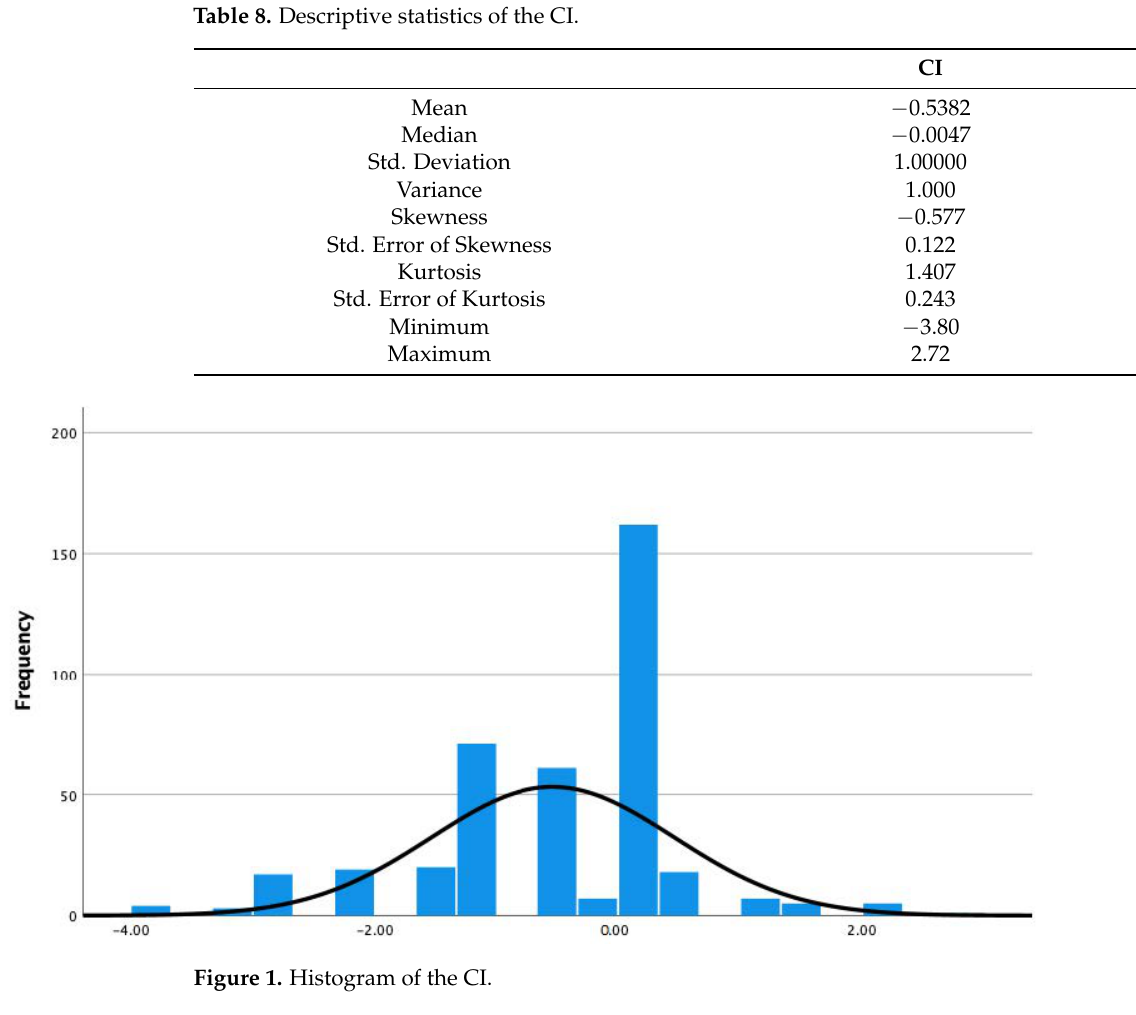
Table 8. Descriptive statistics of the CI.